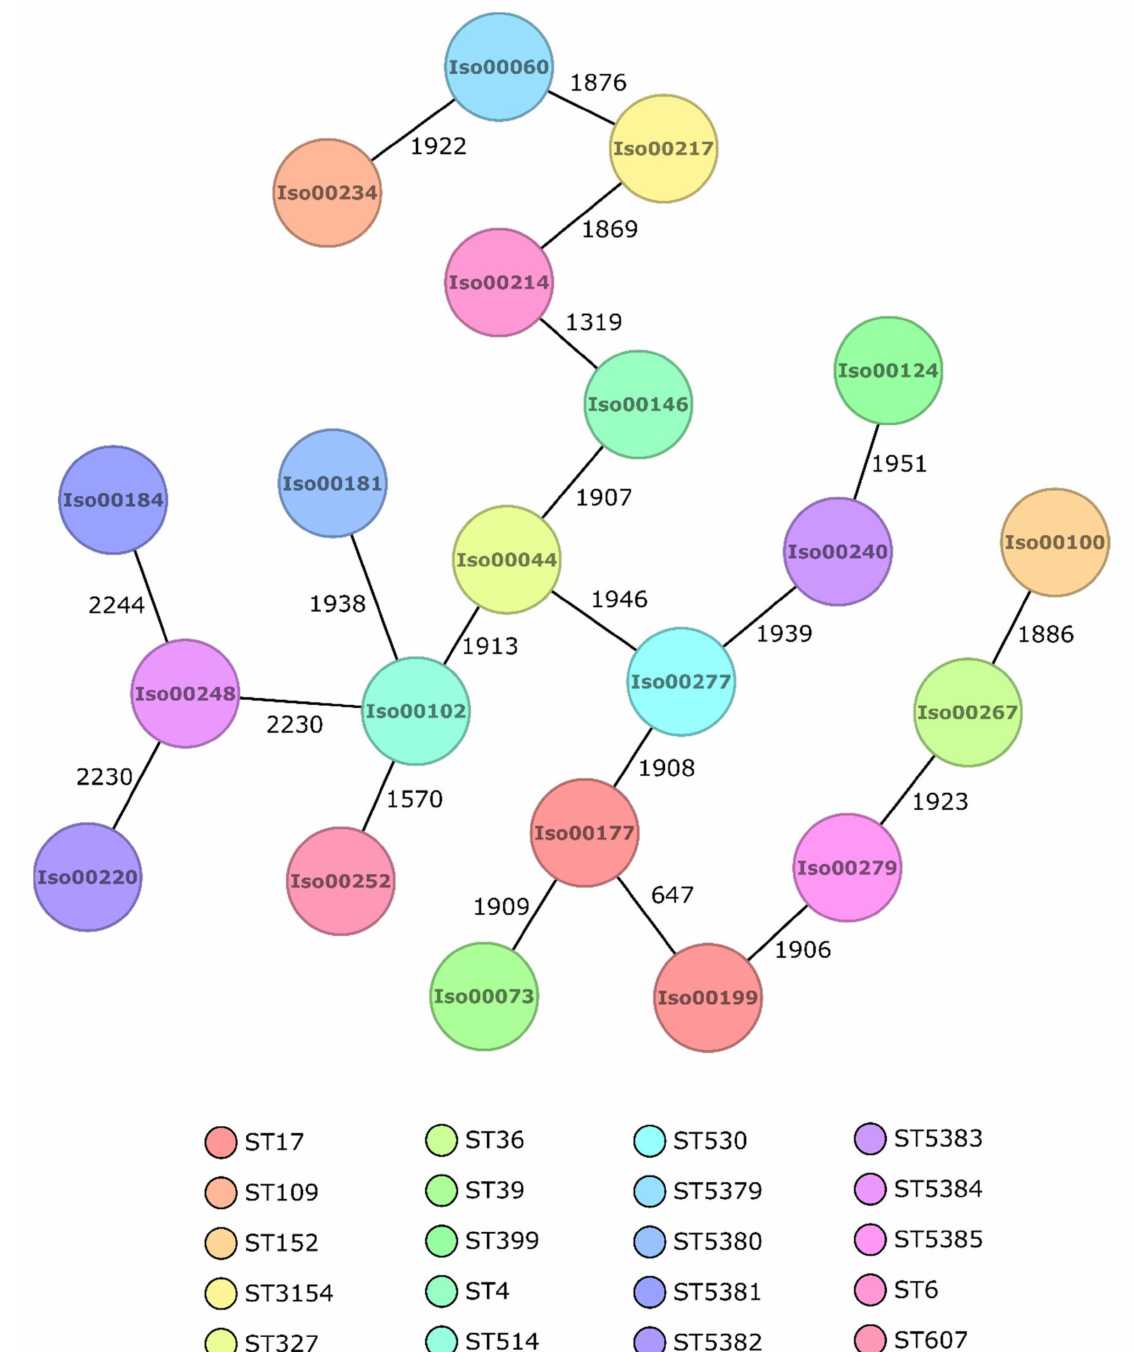
Figure 2. Minimum spanning tree of K. pneumoniae complex based on 2358 targets (core genome). Isolate numbers are found within the nodes, and the numbers between the nodes indicate the number of different alleles. Colors demonstrate the MLST sequence type of the